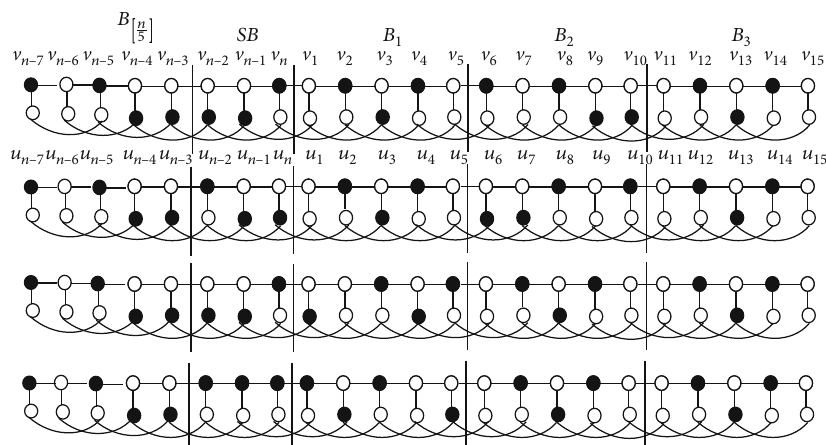
Figure 11: Eternally protecting B